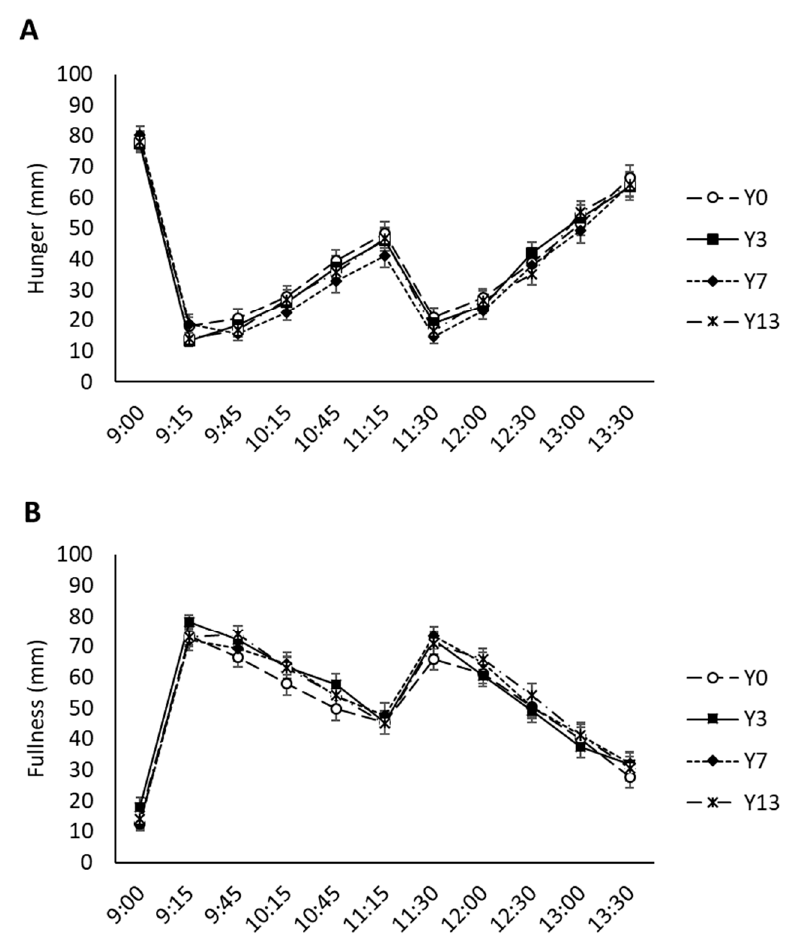
Figure 3. VAS scores of hunger ( A ) and fullness ( B ) rated from the morning meeting in fasting conditions before the standard breakfast (9:00 h) to prior to lunch time (13:30 h).